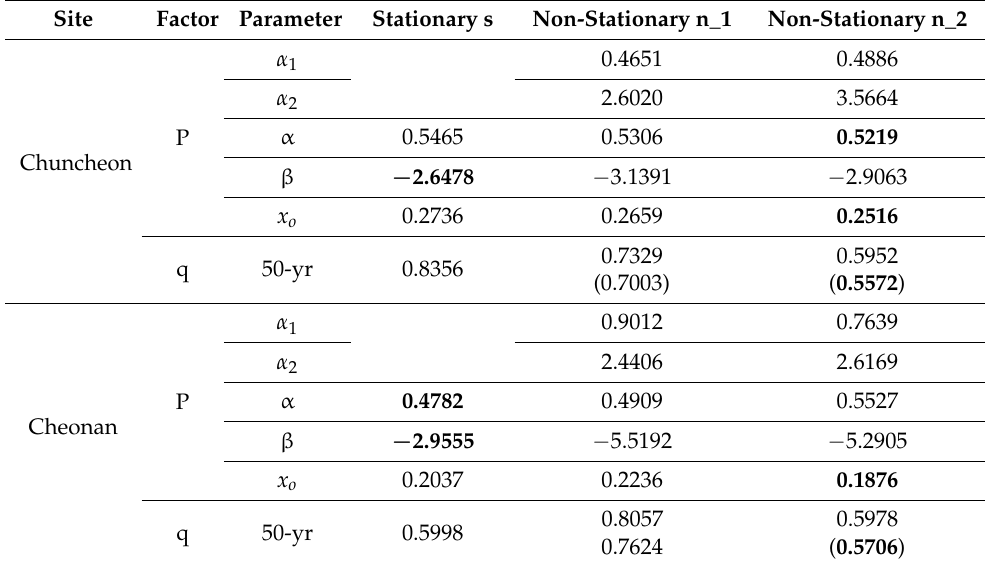
Table 3. Uncertainty of stationary and non-stationary frequency